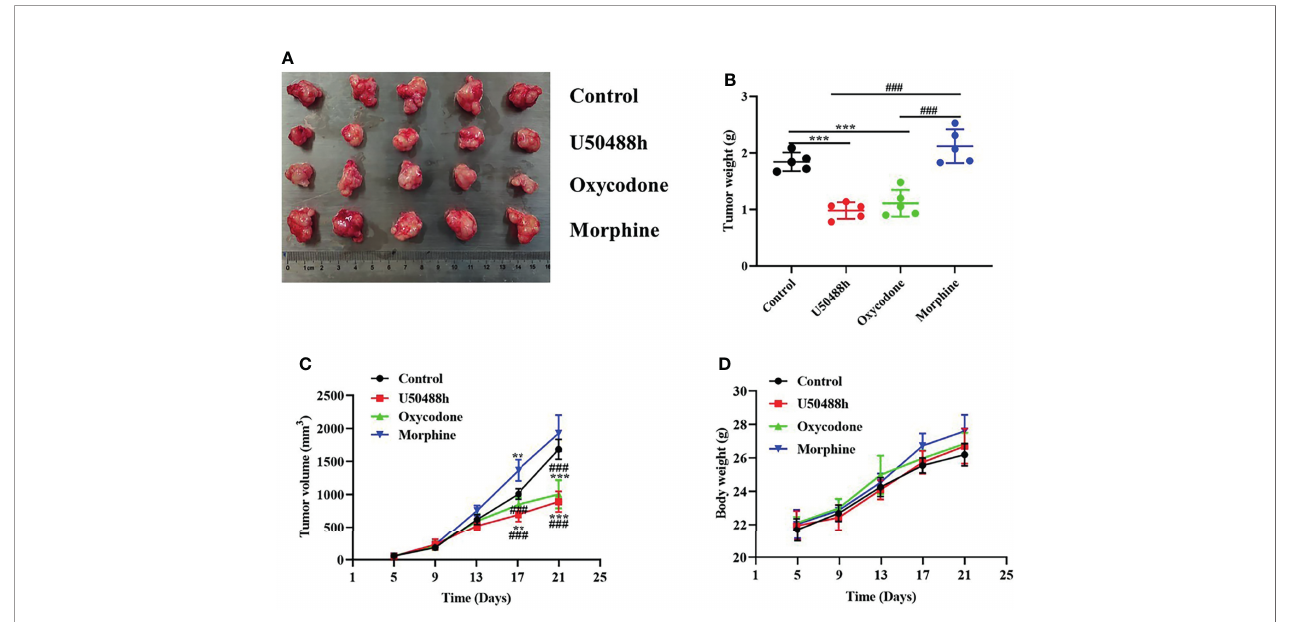
FIGURE 6 | KOR agonist and mixed agonist, oxycodone decreased the tumorigenicity of HCC in vivo . (A) Representative images of tumors in mice treated with PBS and OR agonists. (B, C) Tumor weight and volume of PBS and ORs agonists treated HCC tumors in mice ( n =5). (D) Body weight growth curves of mice over 21days following tumor implantation (n = 5). **P < 0.01, ***P < 0.001 vs. control group; ### P < 0.001 vs. Morphine group.